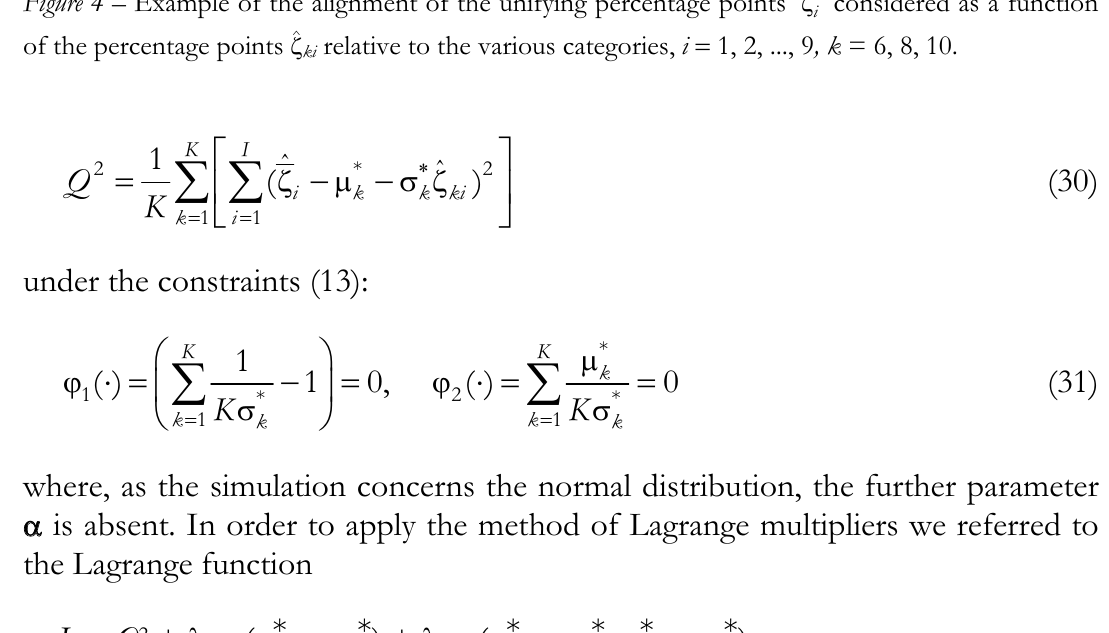
Figure 4 – Example of the alignment of the unifying percentage points ˆ of the percentage points (cid:93) ^ ki relative to the various categories, i (cid:32) 1, 2, ..., 9 , k = 6, 8,